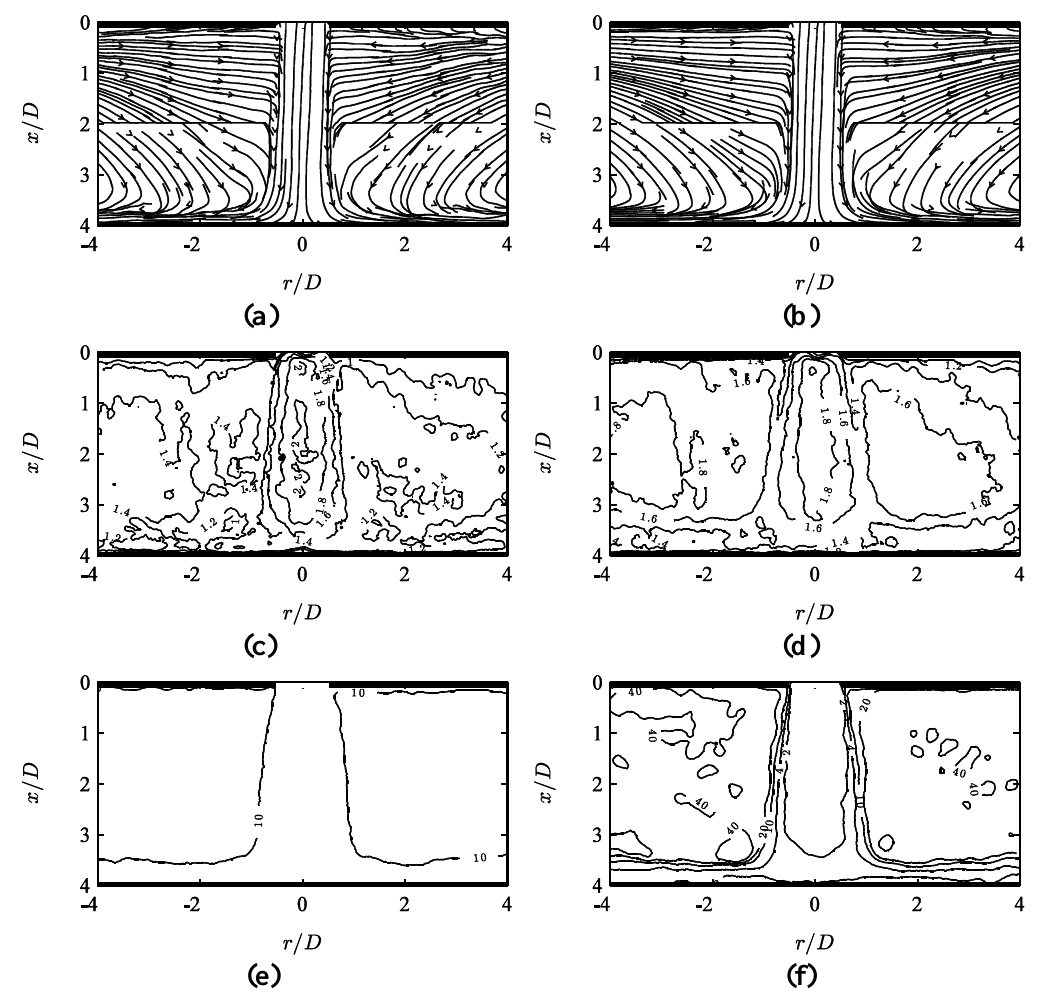
Figure 4. MPS PIV results (  = 0.2 px and p = 5 in Equation (8)) for data acquired s at (a,c,e)  /  = {1, 10} and (b,d,f)  /  = {1, 2, 4, 10, 20, 40, 100}: (a,b) time-averaged min min streamlines, (c,d) weighted peak ratio Q’ ( x , y ) and (e,f) local optimal pulse separation  ( x , y )/  opt min